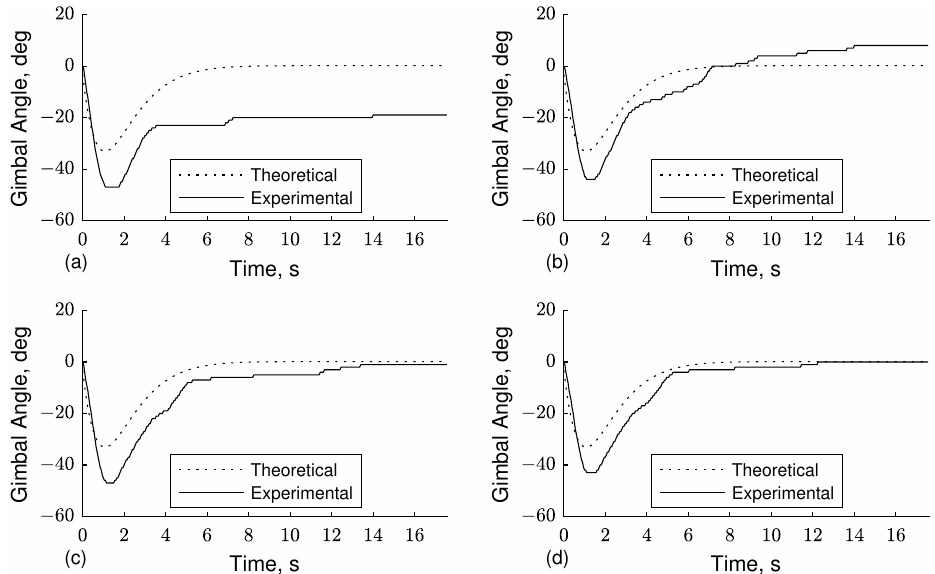
Figure 13. Gimbal angles for 90 deg maneuver, ( a ) δ 1 , ( b ) δ 2 , ( c ) δ 3 , ( d ) δ 4